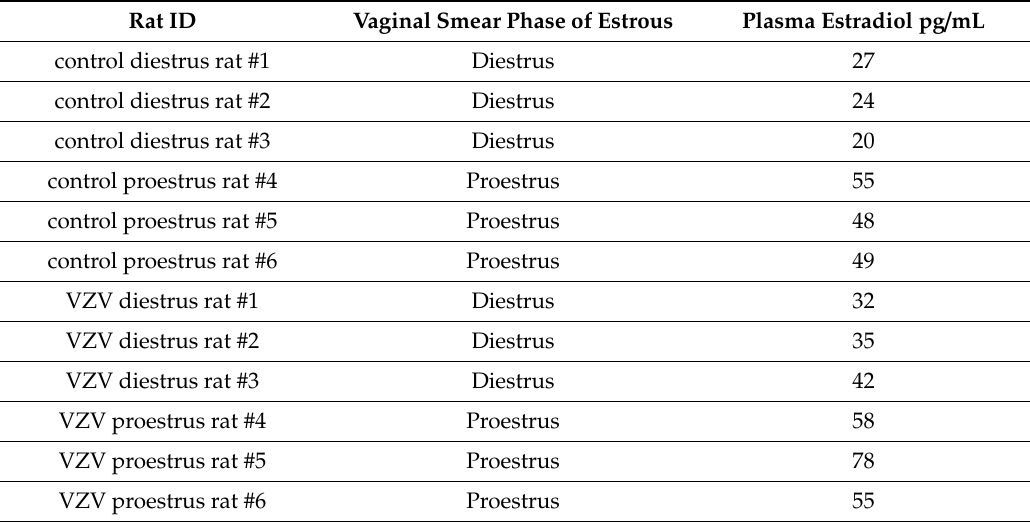
Table 1. Rat estrous phase information for samples used in